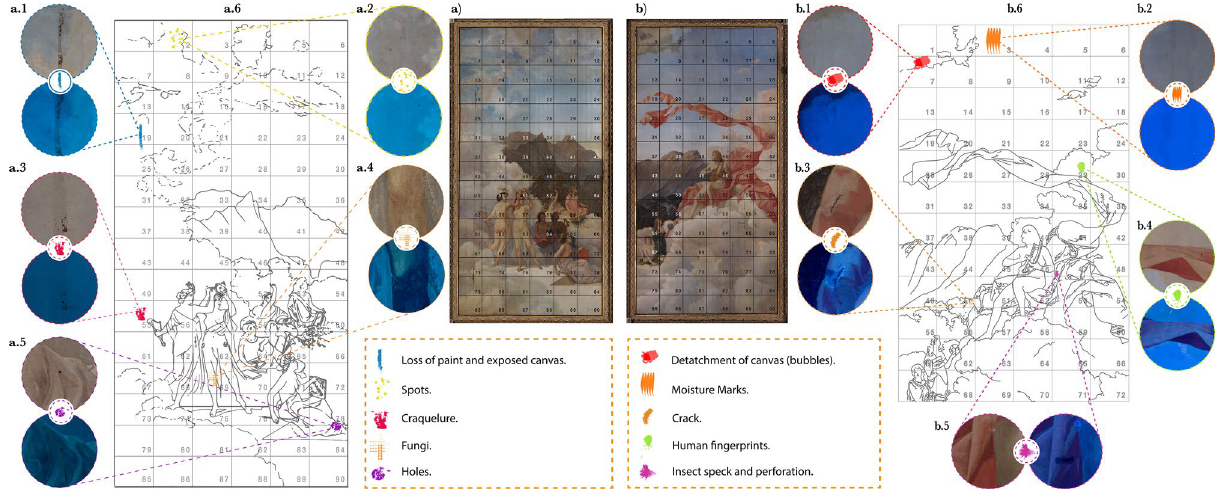
Figure 7. Traces of time: Categorising damage observed in the paintings. Visible photographs of ( a ) Musas II and ( b ) Musas I with the working grid. ( a.6 ) Musas II and ( b.6 ) Musas I diagrams showing locations of the ten most significant types of damage, with visible and UVF images of each: ( a.1. ) Loss of paint and exposed canvas. ( a.2. ) Spots. ( a.3. ) Craquelure. ( a.4. ) Fungi. ( a.5. ) Holes. ( b.1. ) Detachment of canvas (bubbles). ( b.2. )